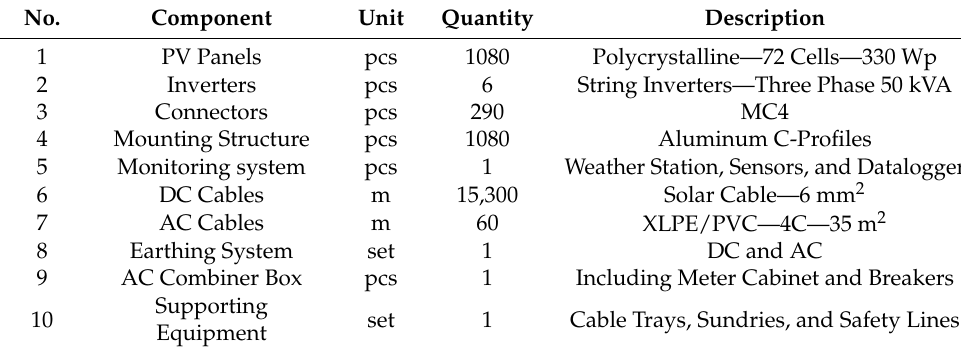
Table 3. PV system components.